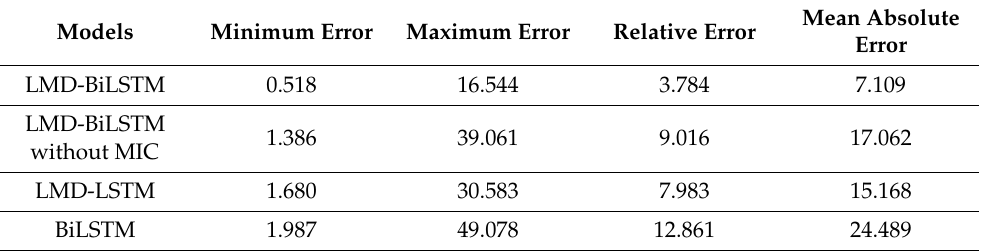
Table 3. Accuracy of the predicted landslide displacement based on the four models.